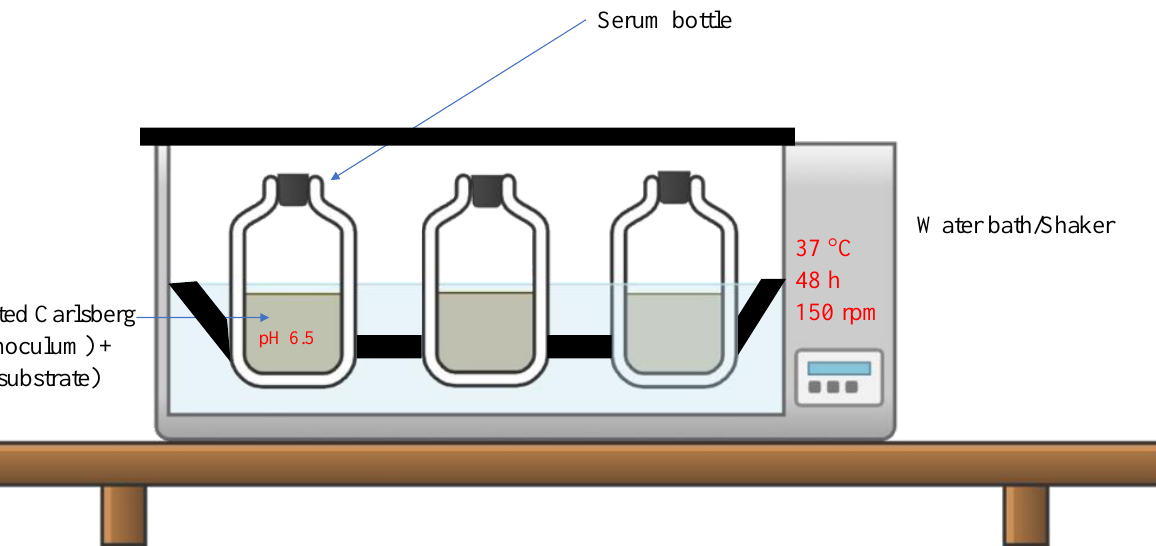
Figure 3. A schematic diagram depicting the incubation of cultures for biohydrogen production during the First Phase.